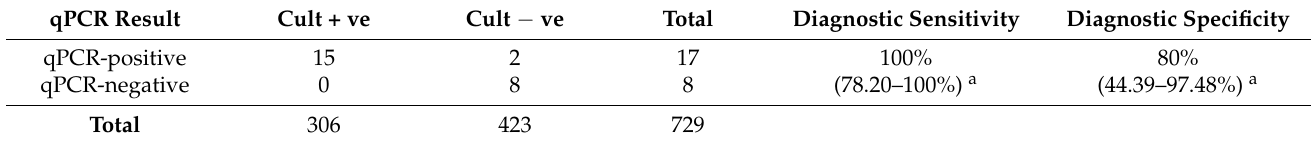
Figure 7. Comparison of LOG values of qPCR, PMA-qPCR, and culture examination. Table 6. Diagnostic sensitivity and specificity of qPCR with combination of PMA